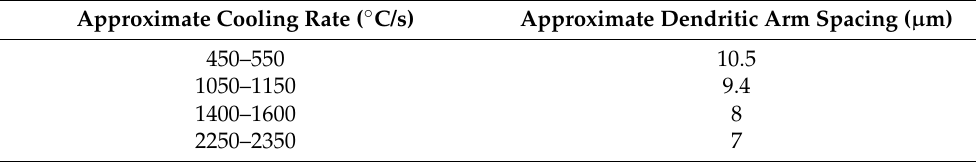
Table 7. Dendritic arm spacing as a function of cooling rate [189].